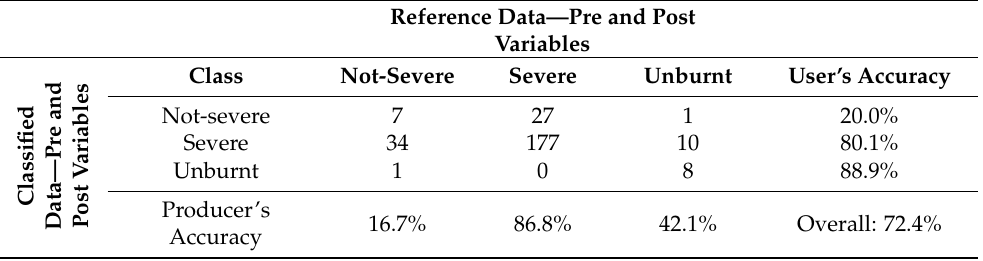
Table 8. Confusion matrix for image-only data stream describing severity of sedgeland segments. Reference Data—Pre and Post